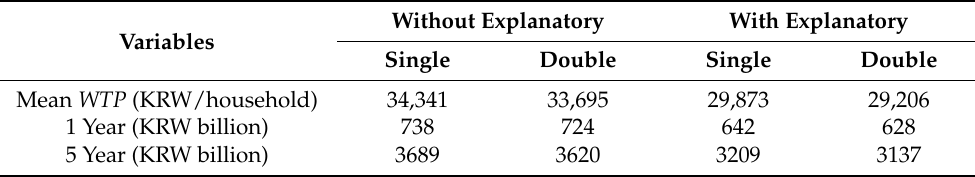
Table 4. Estimated economic value of livestock malodor (2020-based). Without Explanatory With Explanatory Variables Single Double Single Double Mean WTP (KRW/household) 34,341 33,695 29,873